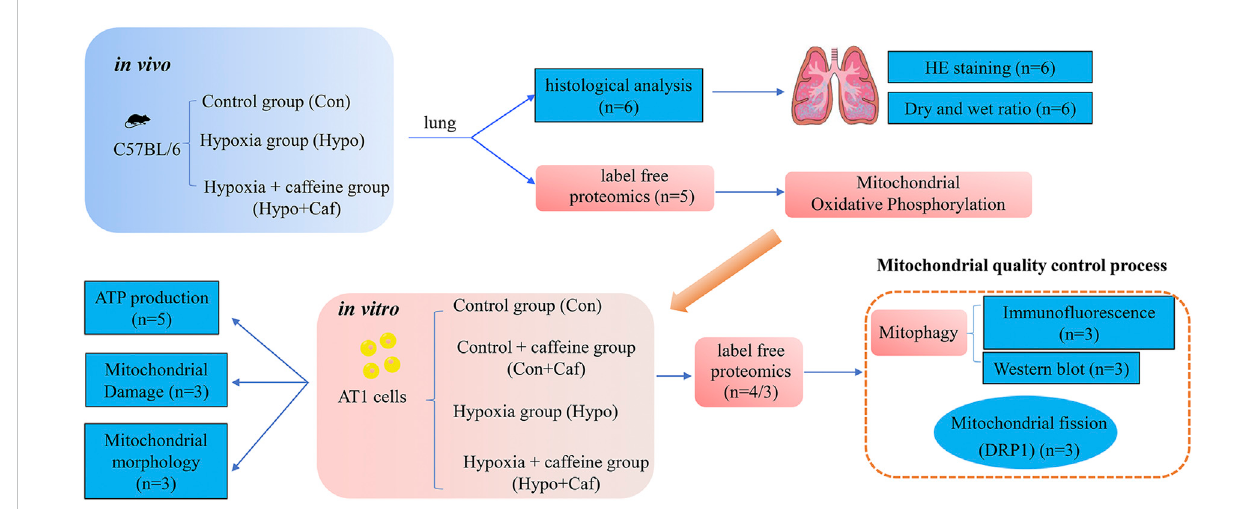
FIGURE 1 The schematic overview of the experimental work fl ow. We designed three groups, consisting of control, hypoxia and hypoxia + caffeine groups for invivo miceexperiments.Viahistologicalandproteomicsanalysisofpulmonarytissues,wetestedthefunctionofcaffeineforHAPEatthetissueleveland discovered mitochondria probably involved in preventing HAPE. Then, we designed four groups (control group, control + caffeine group, hypoxia and hypoxia + caffeine group) in the in vitro AT1 cell-based experiments to detail the function of mitochondria in HAPE via mitochondrial oxidative phosphorylation, ROS synthesis, mitochondrial membrane potential, mitochondrial morphology, mitochondrial fi ssion and proteomics analysis, identifying key mitophagy proteins and